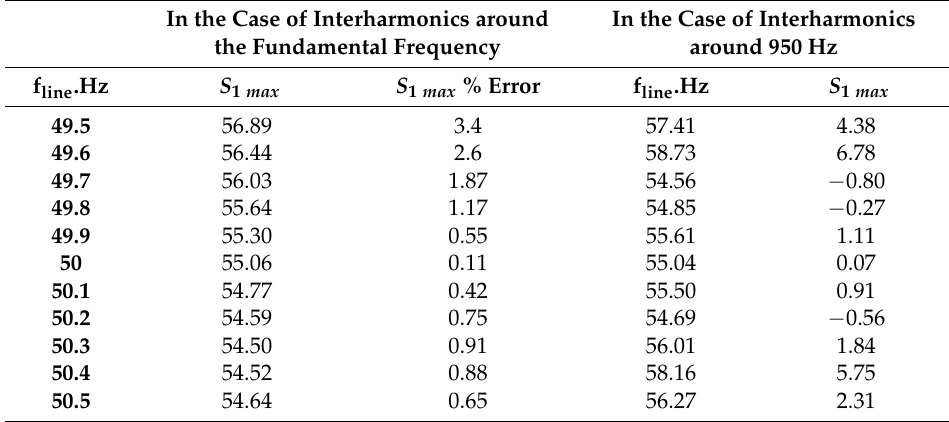
Table 8. Response of proposed flickermeter in the case of Equations (52) and (53).